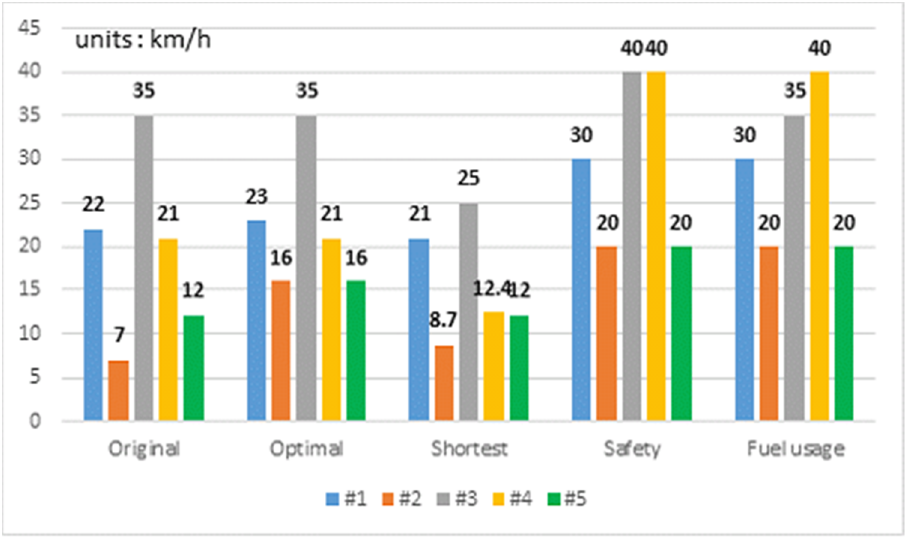
Figure 10. Compare path average speed.